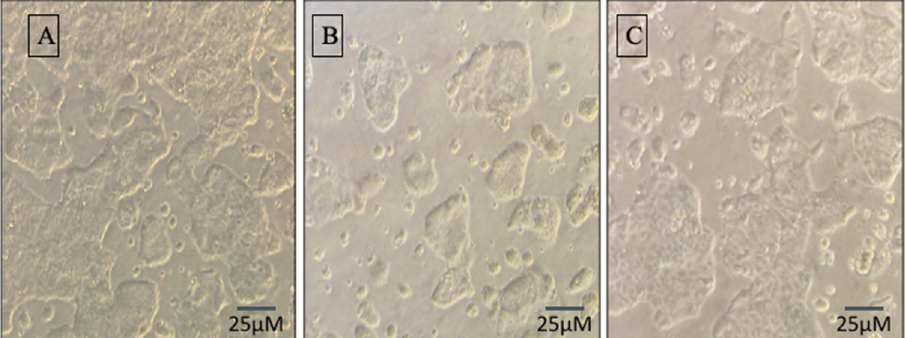
Figure 1. The appearance of Caco-2 cells is enhanced by synbiotic preventive therapy: Caco-2 cells were given the following dosage: ( A ) control, ( B ) ALD model: 100 mM ethanol, ( C ) synbiotic (100 mM + 10 g/mL AGE+ 10 9 CFU/mL cell-free supernatant) and 100 mM ethanol and restored the morphology of cells. All pictures were captured at an ×100.